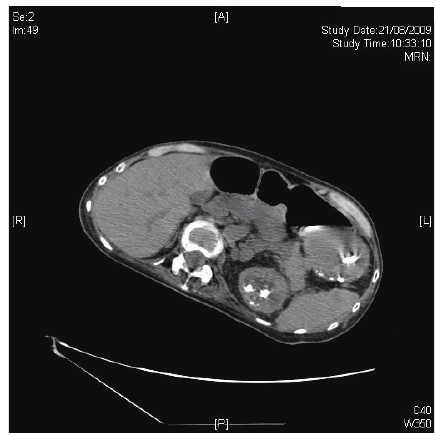
Figure 7: CT abdomen, performed on 21 August 2009, revealed multiple calculi in left kidney.